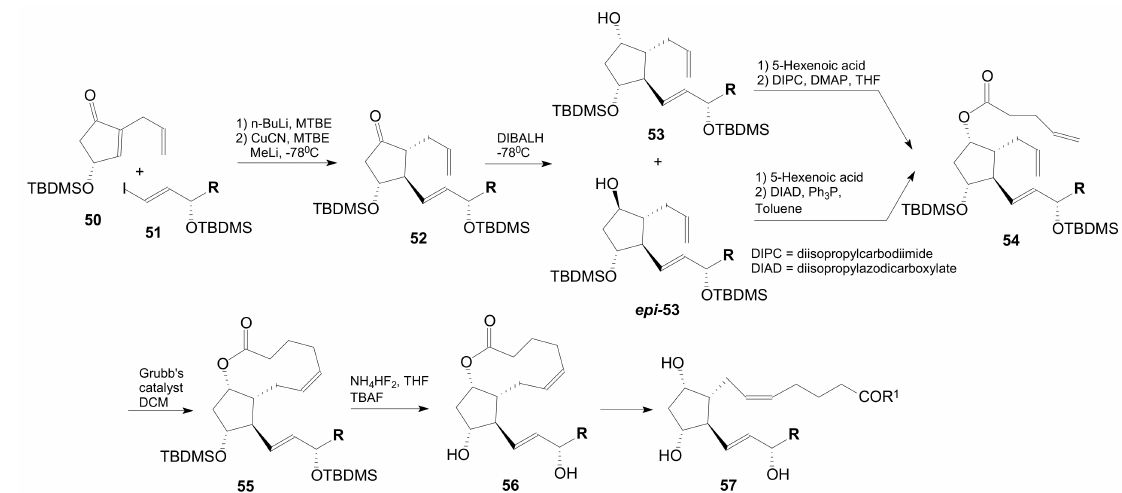
Key intermediate for cis -5-F 2 -isoprostane Scheme 11. A study for the synthesis of the key lactone intermediate 59 by RCM of cyclobutene intermediate 58 and ethylene with the Grubbs’ catalyst 61 . The Hoveyda-Grubbs’ catalyst 62 .